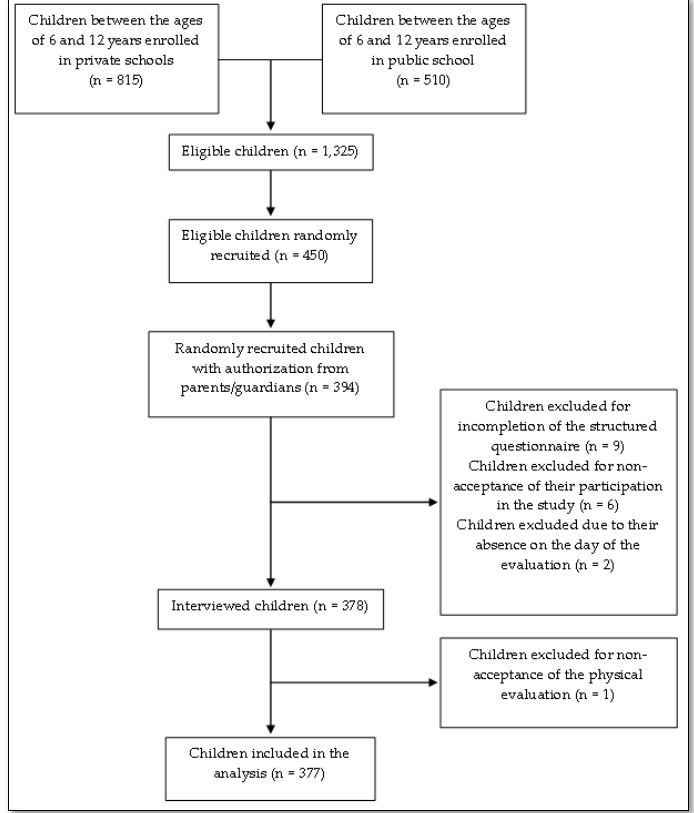
Figure 1. Flowchart of the Research Participants.